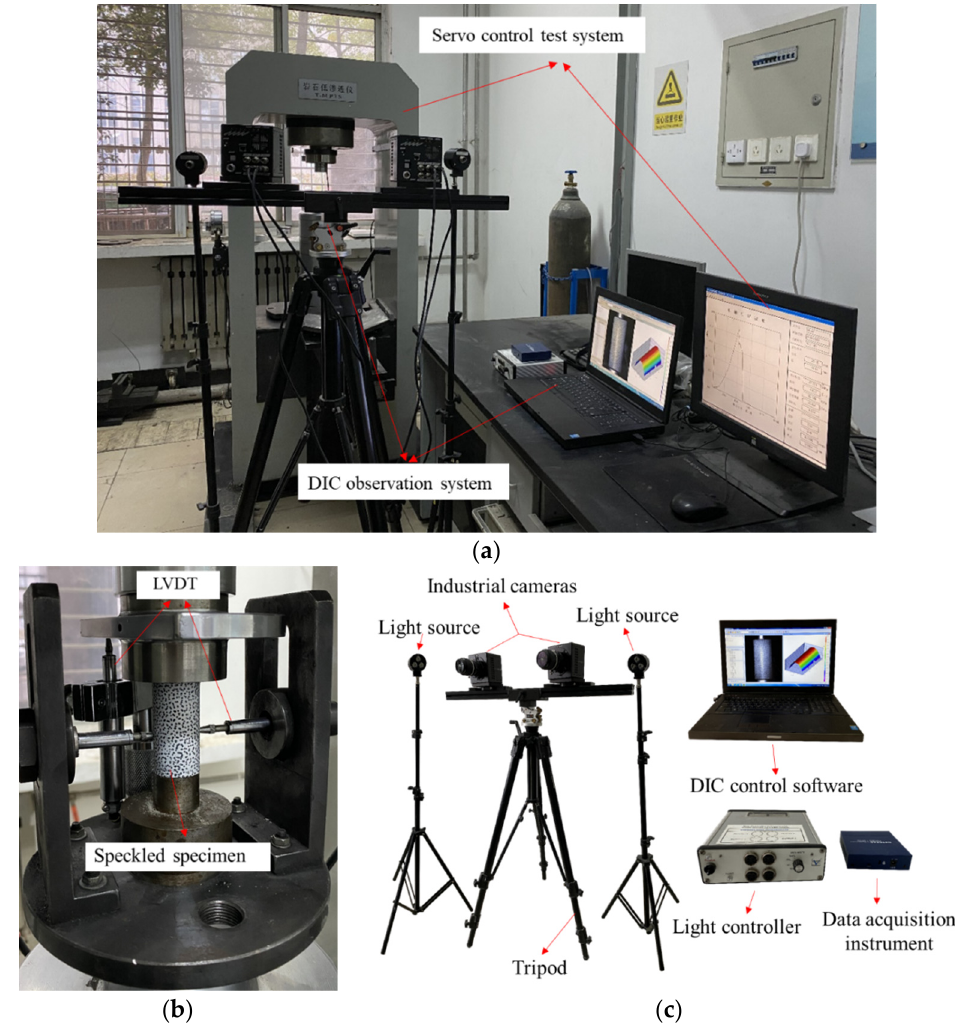
Figure 1. Superimposed static and dynamic loading experimental system: ( a ) full view; ( b ) speckled specimens and loading machine; and ( c ) the DIC observation system.